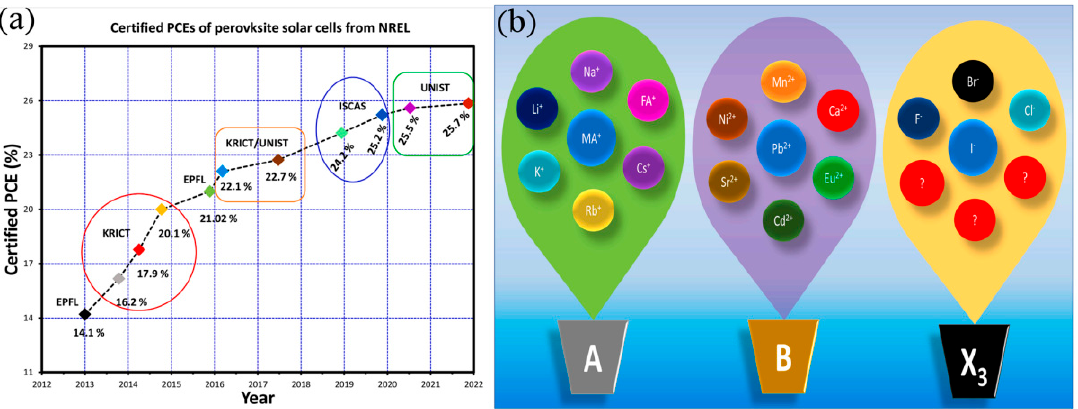
Figure 2. ( a ) Certified PCEs of perovskite solar cells achieved by different groups, data collected from NREL website on 30 March 2022. ( b ) Schematic diagram of ABX3 perovskite with possible A- and B-site (cations) and X-site (anions) dopant passivators (middle circles in blue color indicate the widely used composition of ABX3 PSCs). Reproduced with permission from ref [47].